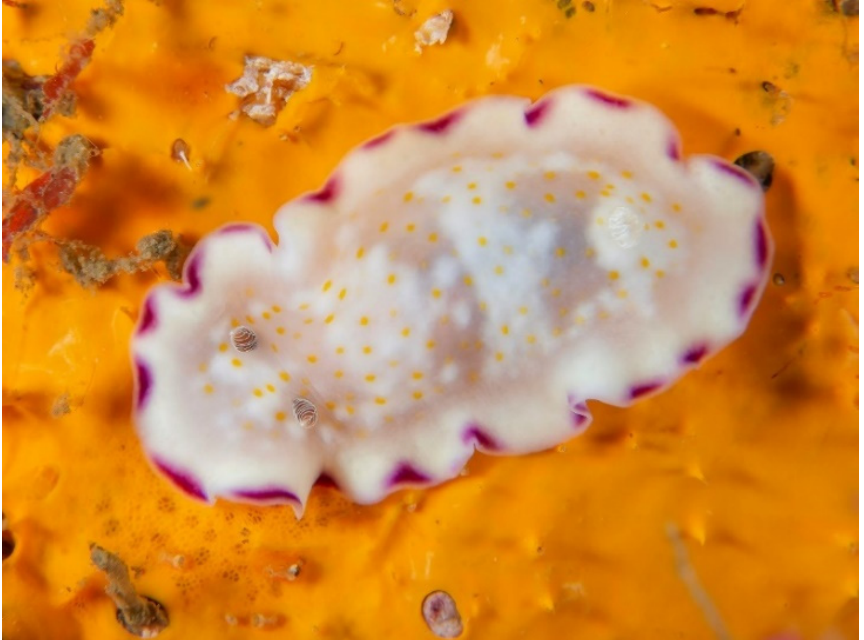
Figure 7. Goniobranchus rufomaculatus , South Solitary Island, NSW, 26 January 2022. Photo: S. D. A. Smith.